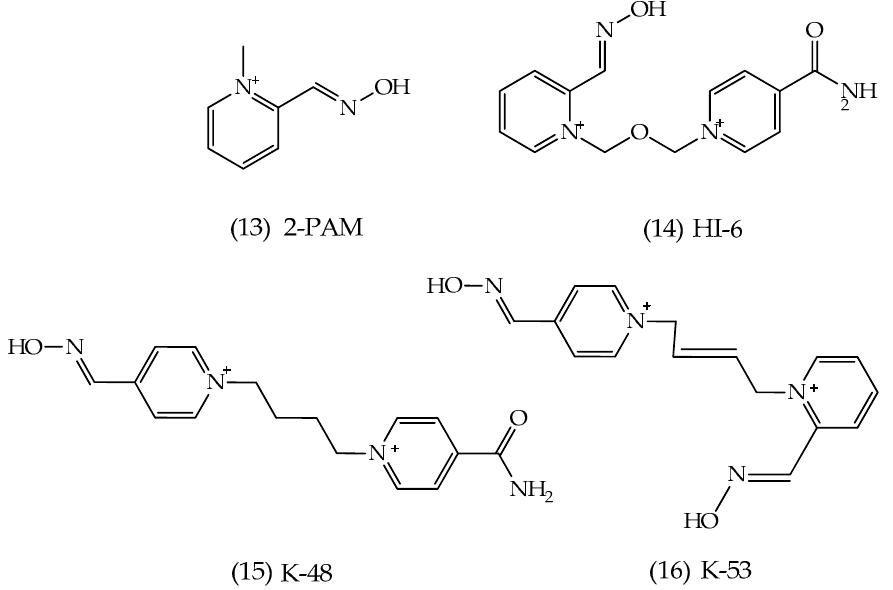
Figure 10. Representation of the chemical structures of oximes.